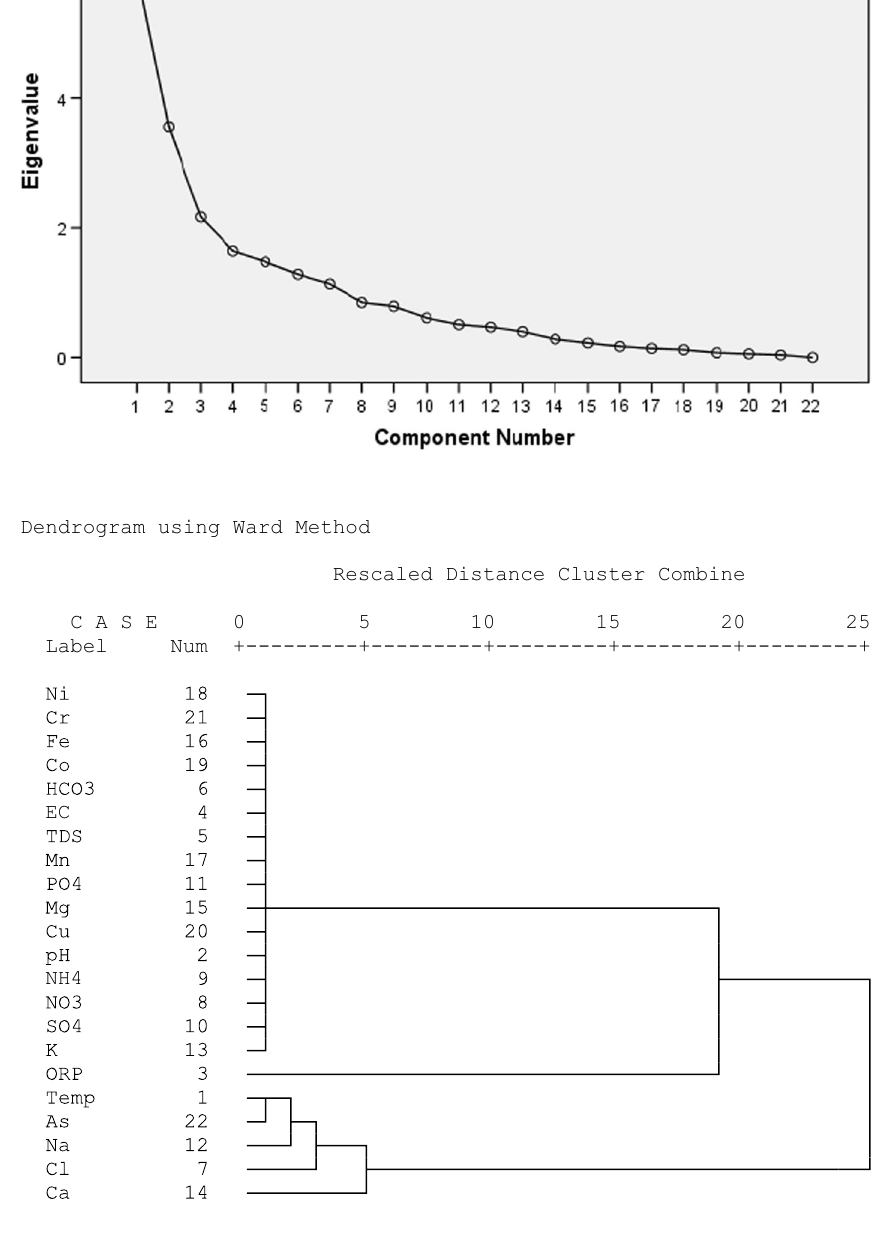
Fig. 2 Scree plots of the eigen- values from PCA during the monsoon season